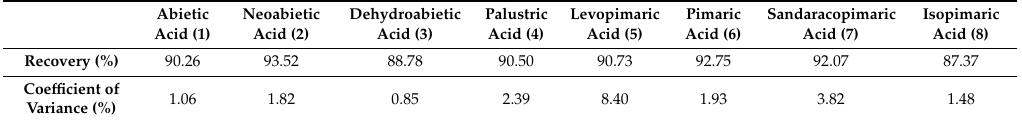
Table 2. Recovery data and their coe ffi cient of variance for the studied resin acids.